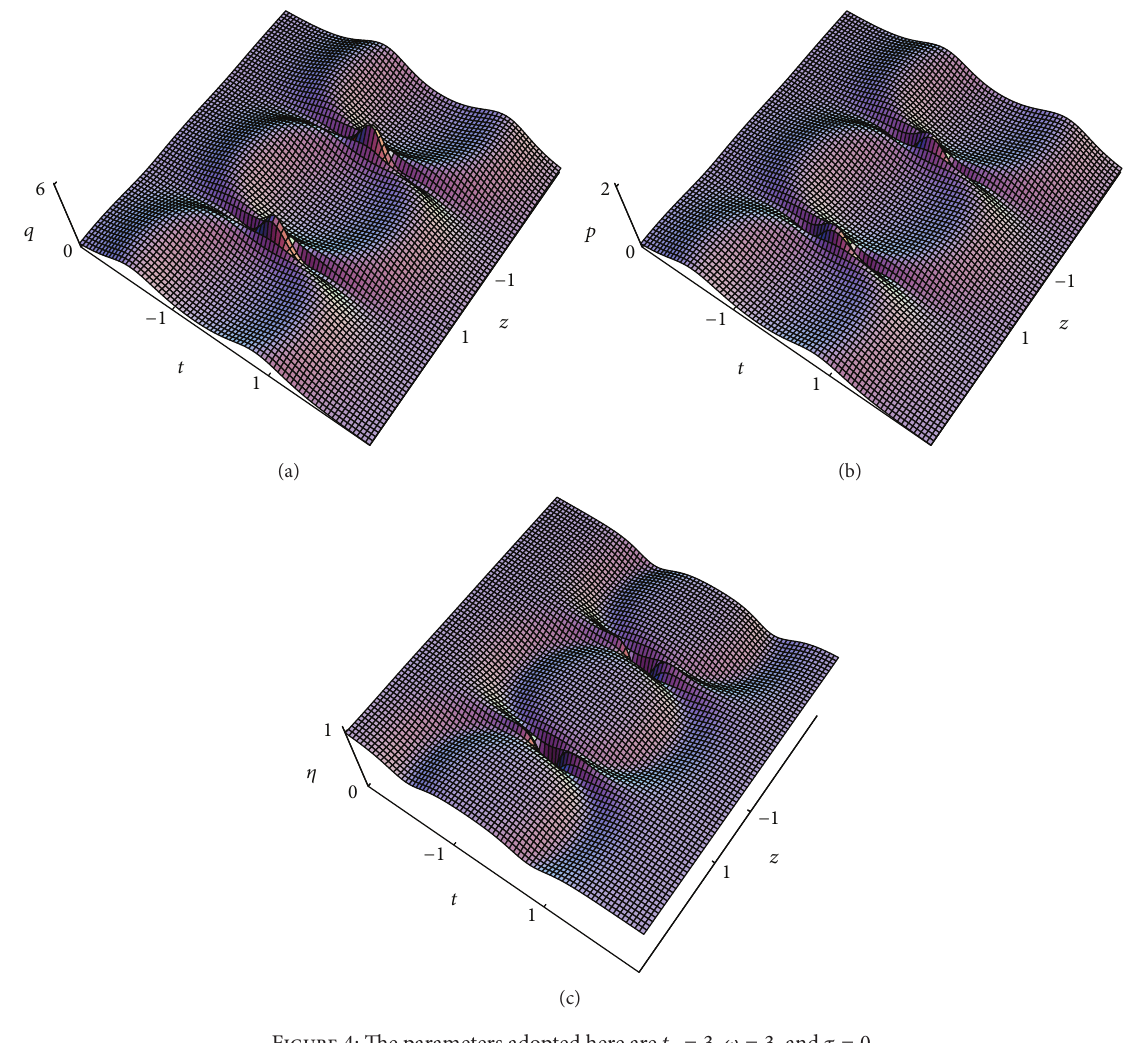
Figure 4: The parameters adopted here are 𝑡 0 = 3 , 𝜔 = 3 , and 𝜏 = 0